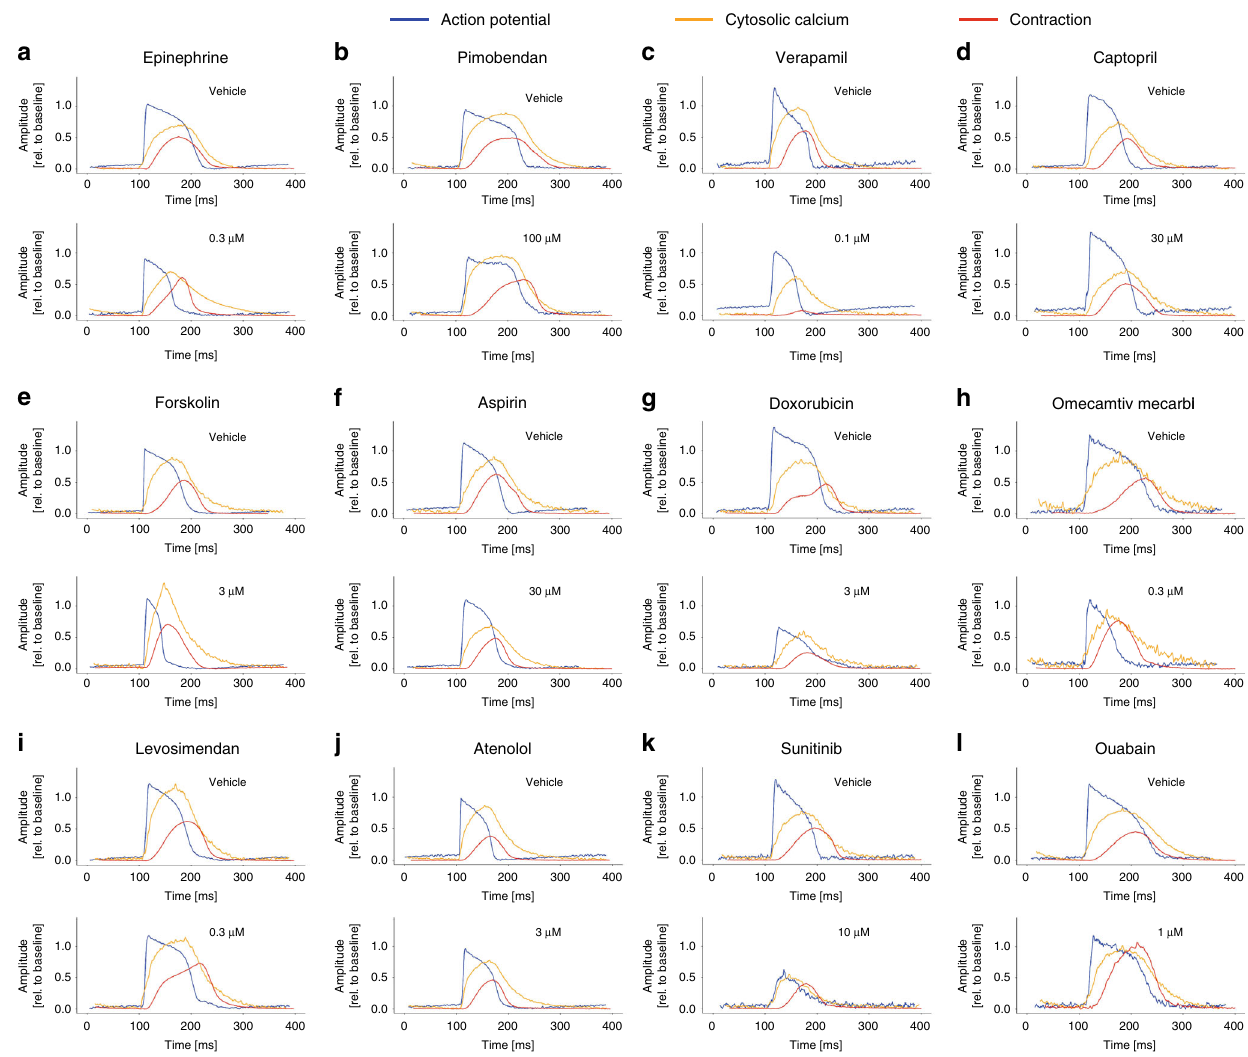
Fig. 4 Averaged representative transients of hiPSC-CMs in response to vehicle (DMSO) and drugs. All measurements were normalized to their individual baseline measurements. Cells were paced at 1.2 Hz. Simultaneous measurements show action potential (blue), cytosolic calcium (orange) and contraction (red) of Pluricytes under baseline conditions and in response to 0.3 µ M epinephrine ( a ), 100 µ M pimobendan ( b ), 0.1 µ M verapamil ( c ), 30 µ M captopril ( d ), 3 µ M forskolin ( e ), 30 µ M aspirin ( f ), 3 µ M doxorubicin ( g ), 0.3 µ M omecamtiv mecarbil ( h ), 0.3 µ M levosimendan ( i ), 3 µ M atenolol ( j ), 10 µ M sunitinib ( k ) and 1 µ M ouabain ( l